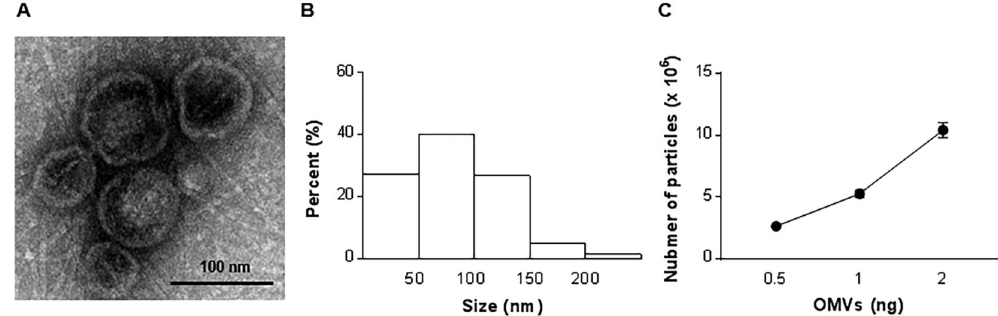
Figure 1. Characterization of E. coli -derived OMVs. ( A ) Transmission electron microscopy image of purified OMVs. Scale bar, 200 nm. ( B ) Size distribution of OMVs according to diameter. The size total 1189 OMVs were determined by using the IMOD program. ( C ) The OMVs particle number per OMVs proteins measured by nanoparticle tracking